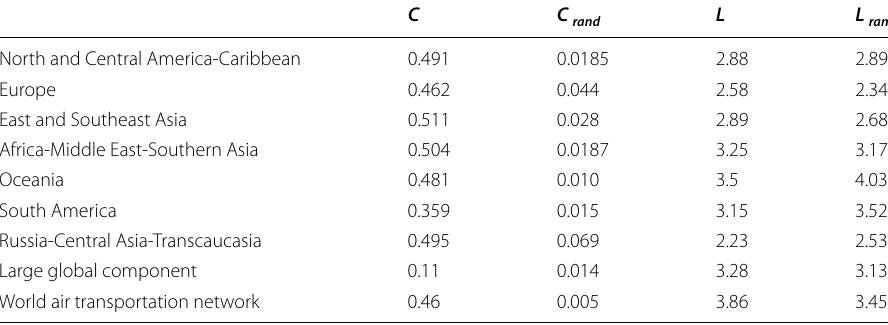
Table 3 Small-world property of the components C C rand L L rand North and Central America-Caribbean 0.491 0.0185 2.88 2.892 Europe 0.462 East and Southeast Asia 0.511 Africa-Middle East-Southern Asia 0.504 Oceania 0.481 South America Russia-Central Asia-Transcaucasia 0.495 2.23 2.531 Large global component 0.11 0.014 3.28 3.13 World air transportation network C and C rand are respectively the clustering coefficients of the local components and the random network with same number of nodes and links. L and L rand are respectively the average shortest path length of the components and their corresponding random network